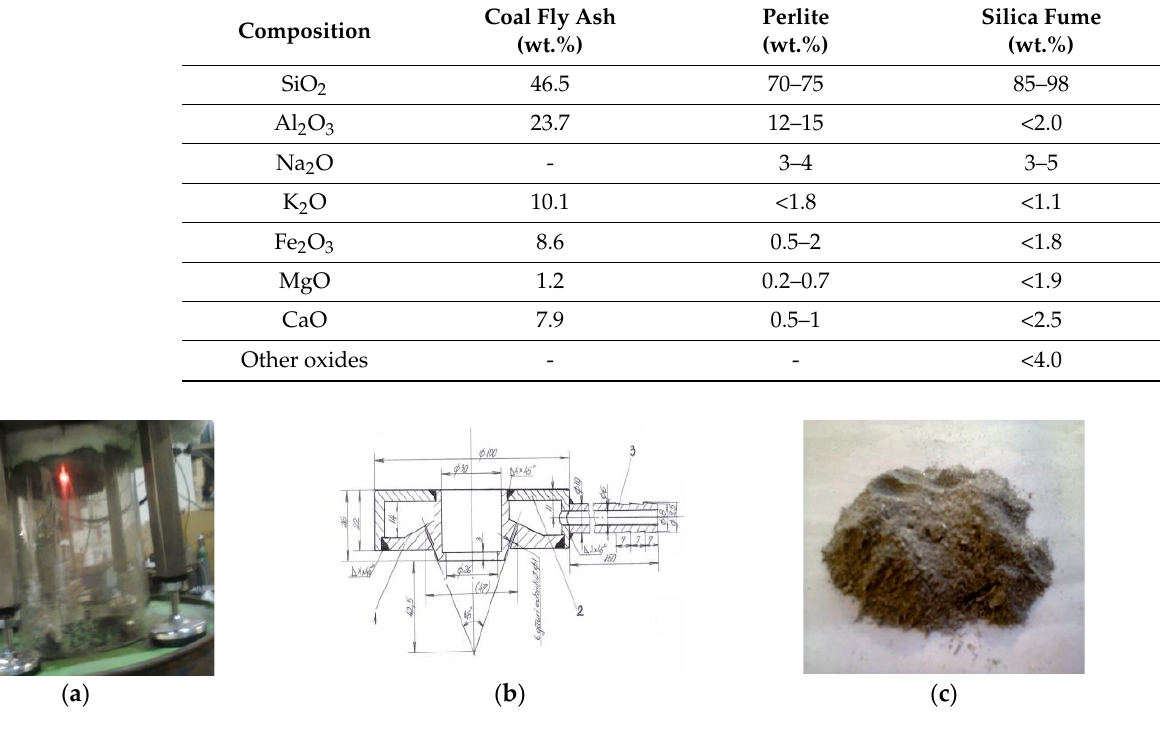
Figure 1. The details of the atomization of molten aluminum: ( a , b ) the atomization area of the installation; ( c ) the batch of aluminum powder (reproduced with permission from Junkoeko SRL Slobozia, Romania).